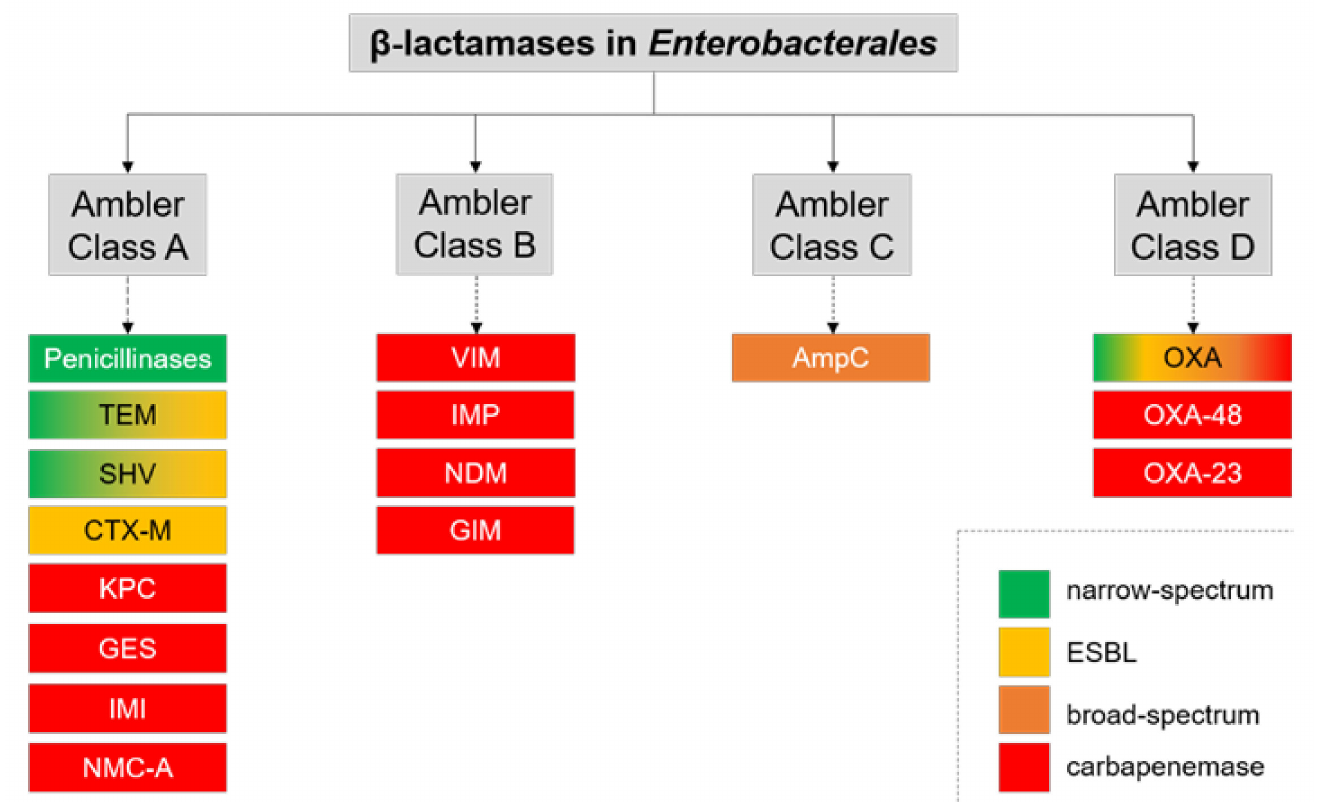
Figure 1. Ambler’s classification with examples of main β -lactamases in Enterobacterales